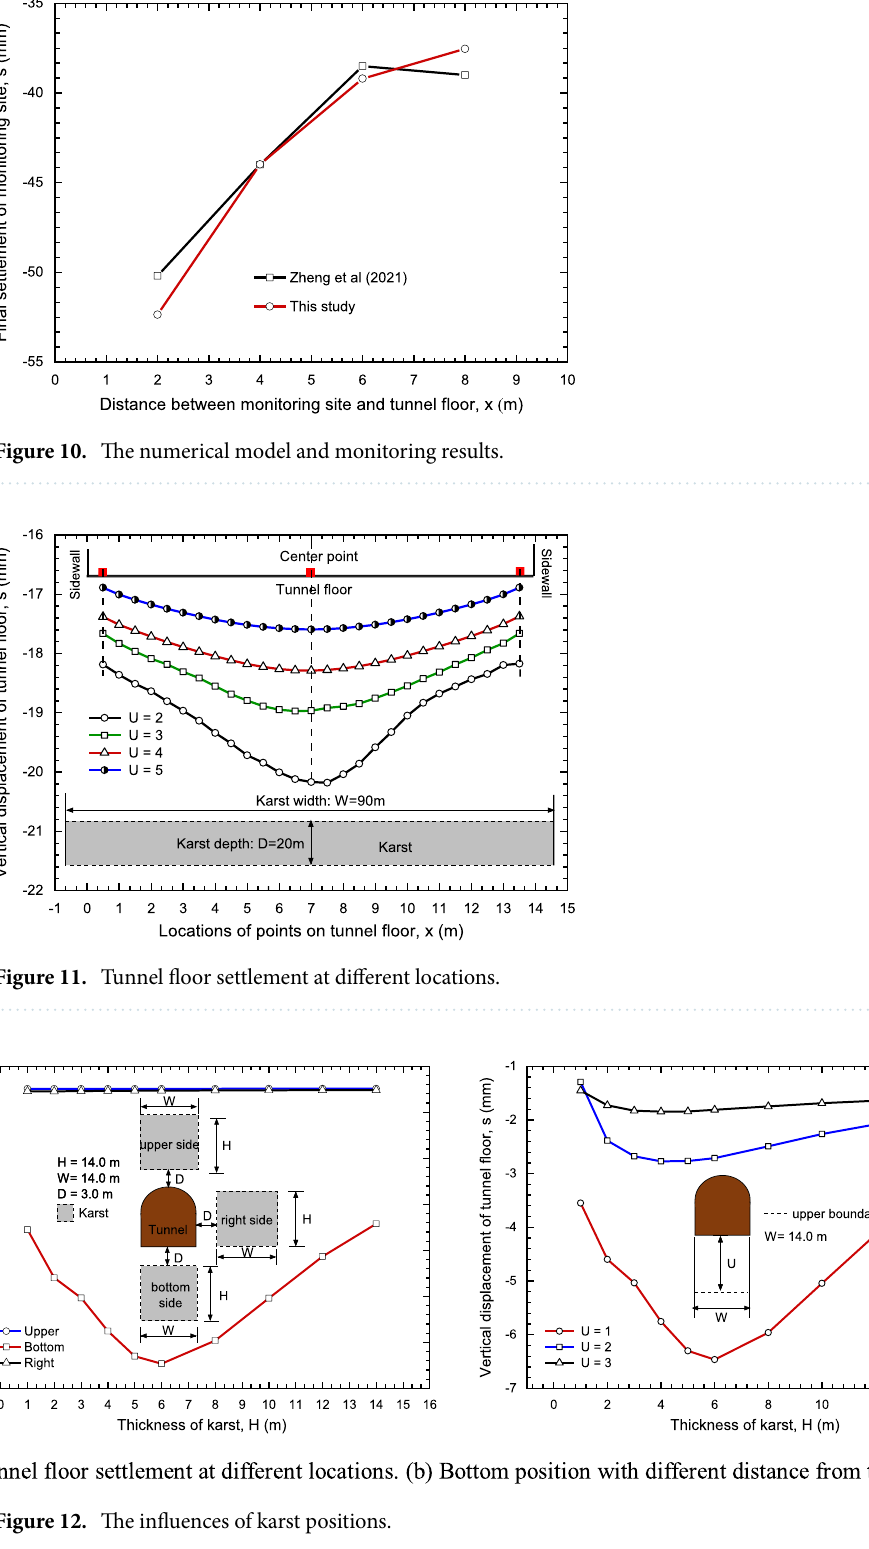
Figure 12. The influences of karst